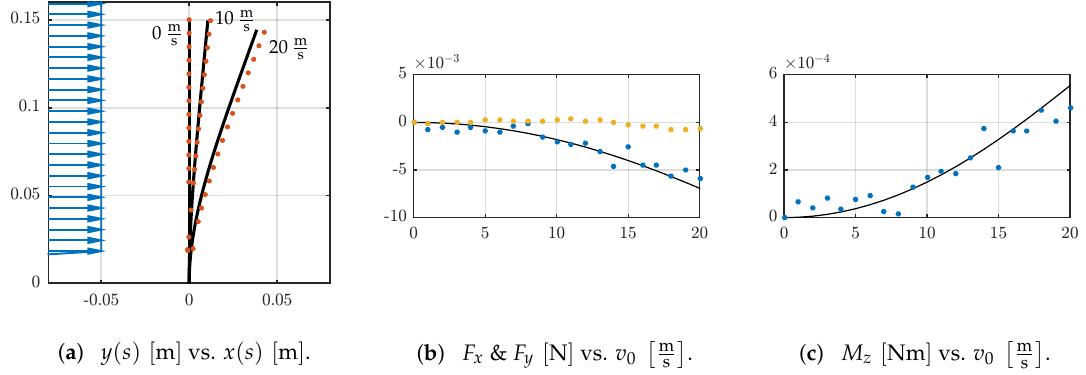
Figure 7. ( a ) The flow velocity profile v ( y ) (blue) is qualitatively shown for v 0 = 20 m and the deformed s shapes of the shaft D03 for v 0 = ˜ v m , ˜ v ∈ { 0,10,20 } in experiment (red) and simulation (black solid s line). Support reactions in experiment ( b ) F x (blue), F y (yellow) and ( c ) M z (blue); each in dependence on the flow velocity v 0 and corresponding simulations (black solid lines).